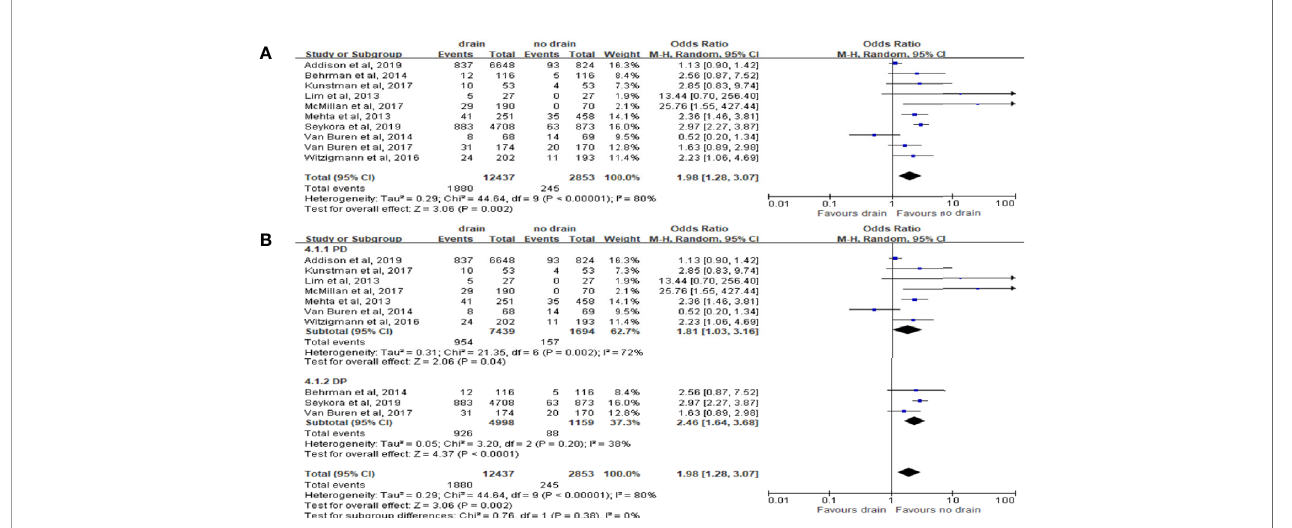
FIGURE 5 | Forest plot of the comparison of the rate of CR-POPF in drain versus no-drain groups after pancreatic resection. (A) Comparison in overall; (B) comparison in PD and DP subgroups,